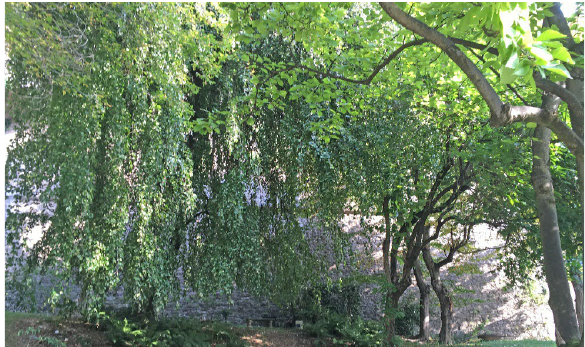
Figure 7. A portion of city walls hidden by nearby